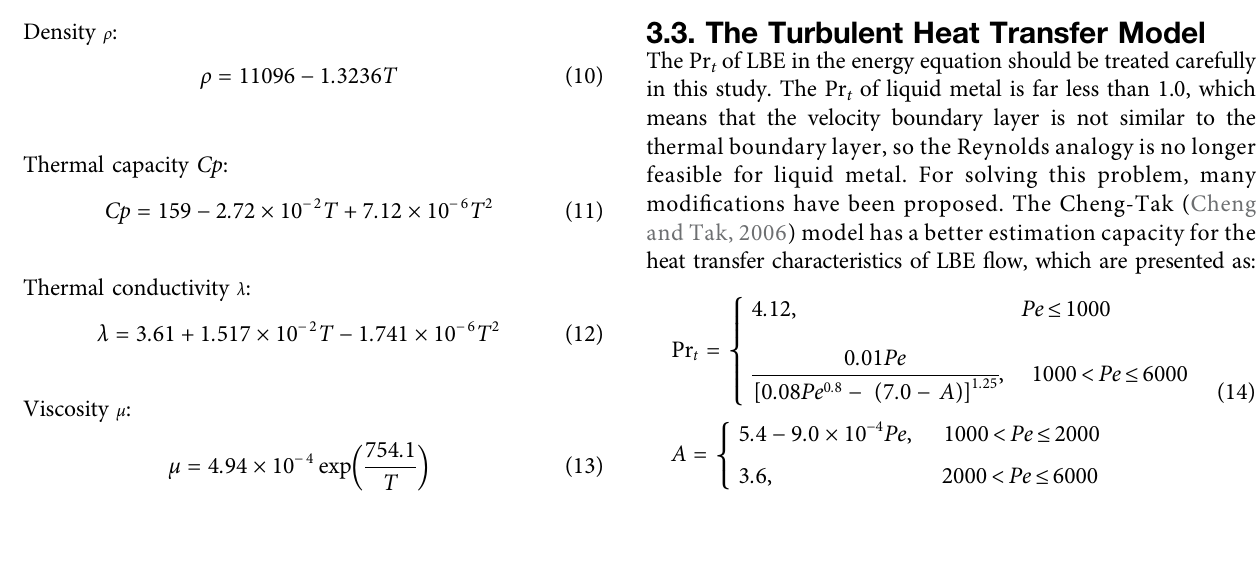
Frontiers in Energy Research |